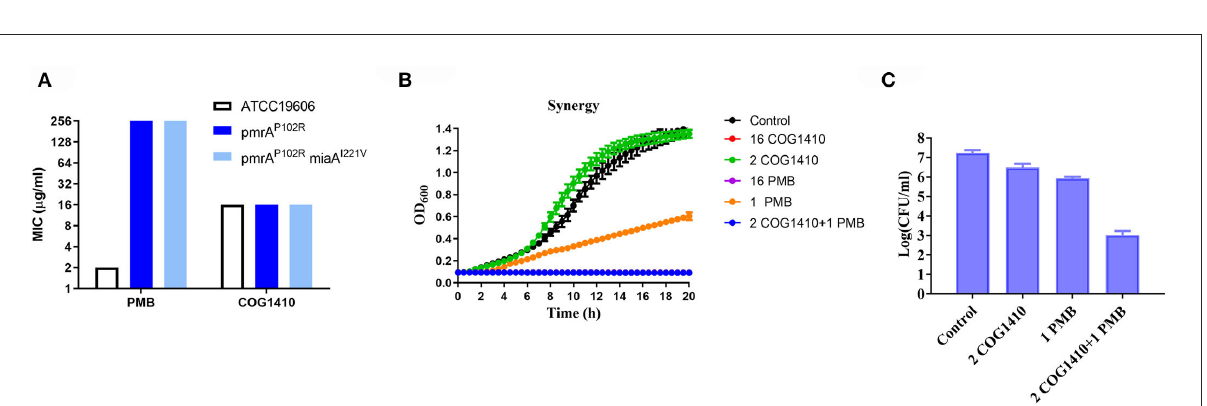
FIGURE7 COG1410 exhibited strong synergistic interaction with polymyxin B. (A) Modification of LPS did not change the antimicrobial activity of COG1410 against A. baumannii . MIC was determined against A. baumannii wild-type strain ATCC19606 and the corresponding LPS-defective mutants with pmrA P102R and pmrA P102R miaA I221V mutation in LB broth. (B) The combination of 2 µ g/ml COG1410 and 1 µ g/ml polymyxin B could completely inhibit bacterial growth within 20h in the LB broth. The growth curve was measured in duplicate, with eight wells for each treatment in a 96-well plate each time. The representative one was displayed. (C) The combination of COG1410 and polymyxin B significantly reduced the CFU of A. baumannii YQ4 in PBS. Experiments were conducted in triplicate. Data indicated mean ± SD